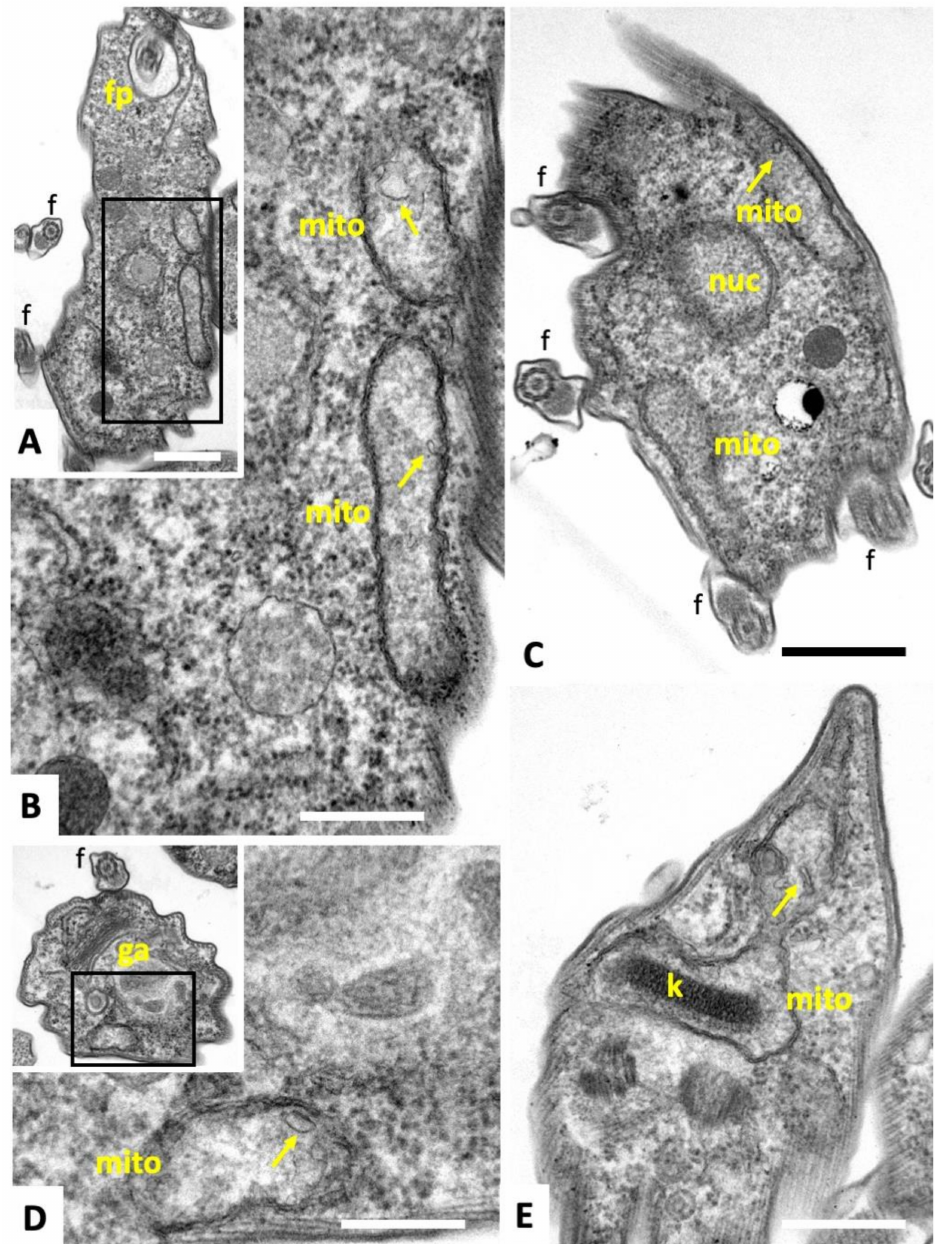
Figure 4. TEM of T. brucei bloodstream forms. ( A , B ) shows longitudinal sections through the cytoplasm of a parasite cultured in the absence of compounds, with the boxed area in A magnified in B highlighting parts of the mitochondrion. ( C , D ) show cross-sections of parasites cultured in the presence of compounds 2 and 3 , respectively, both at 200 nM for 4 h. In D , the boxed area in the low magnification view is enlarged. ( E ) shows a section through the posterior part of a parasite treated with 3 . Note the highly ordered kinteoplast structure (k) and partially exposed mitochondrion (mito) that exhibits a rather amorphous and slightly electron-dense matrix with only few cristae-like structures (arrows); ga = golgi apparatus, k = kinetoplast, f = flagellum, fp = flagellar pocket. Bar in A = 0.35 µ m; in B = 0.2 µ m; in C = 0.3 µ m; in D = 0.2 µ m; in E = 0.3 µ